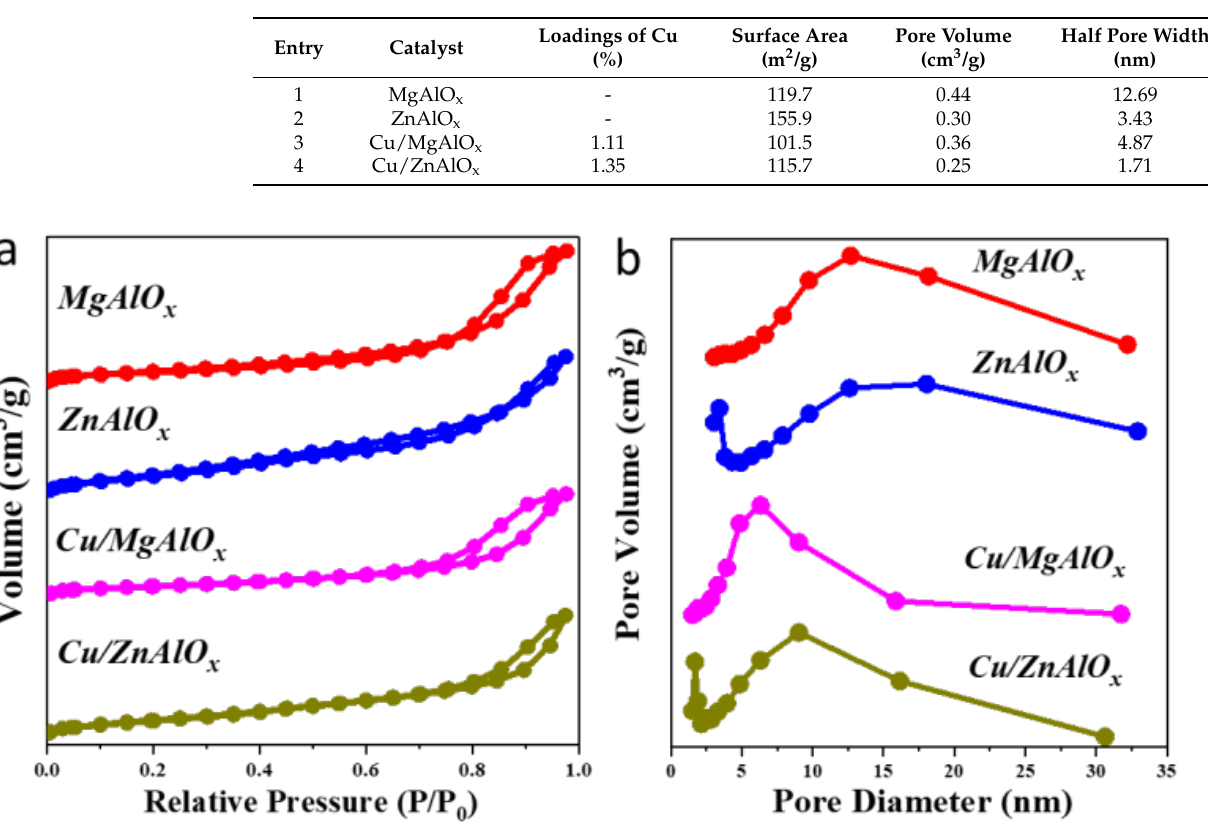
Figure 2. ( a ) N 2 physical adsorption-desorption isotherms and ( b ) BJH-pore size distributions of mixed oxides and supported Cu catalysts.